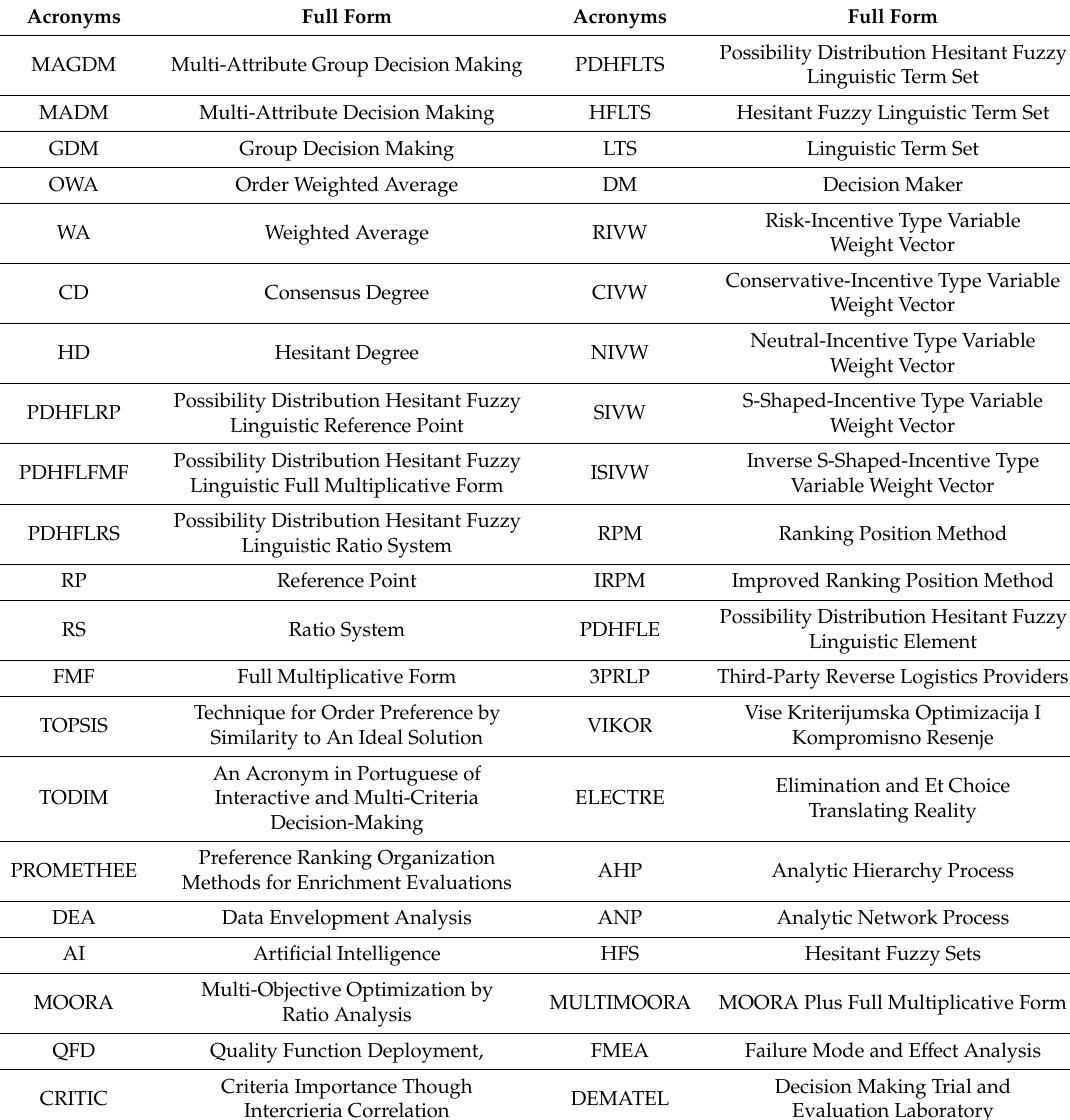
Table 1. Definition of